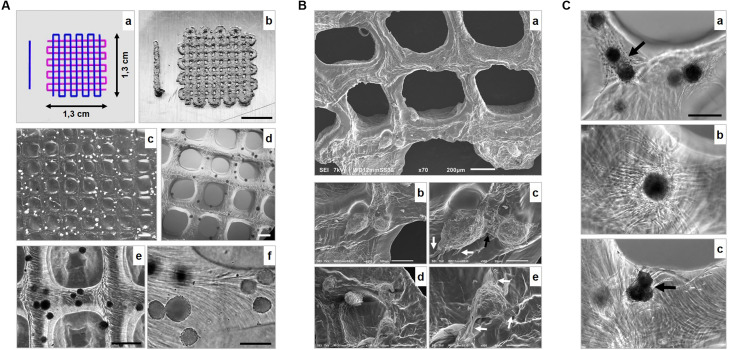
3D bioprinting of 14-day-mature cartilage microtissues in gelMA/Li-TPO-L (A) Representation of (a) the CAD model and (b–f) macroscopic to microscopic representation of the printed scaffolds. Scale bars 500 μm (b), 800 μm (c), 500 μm (d,e), 200 μm (f). (B) Scanning Electron Microscopy (SEM) evaluation of bioprinted scaffolds. Black arrow indicates cellular sprouts of adjacent spheroids making contact, initiating fusion (b) and white arrows (b,c) indicate cellular outgrowth. Scale bar 200 μm (a), 100 μm (b,d), 50 μm (c,e). (C) Fusion and cellular outgrowth of spheroids 4 days (a) and 14 days (b,c) post printing within the gelMA. Black arrows indicate tissue fusion. Scale bar 200 μm.